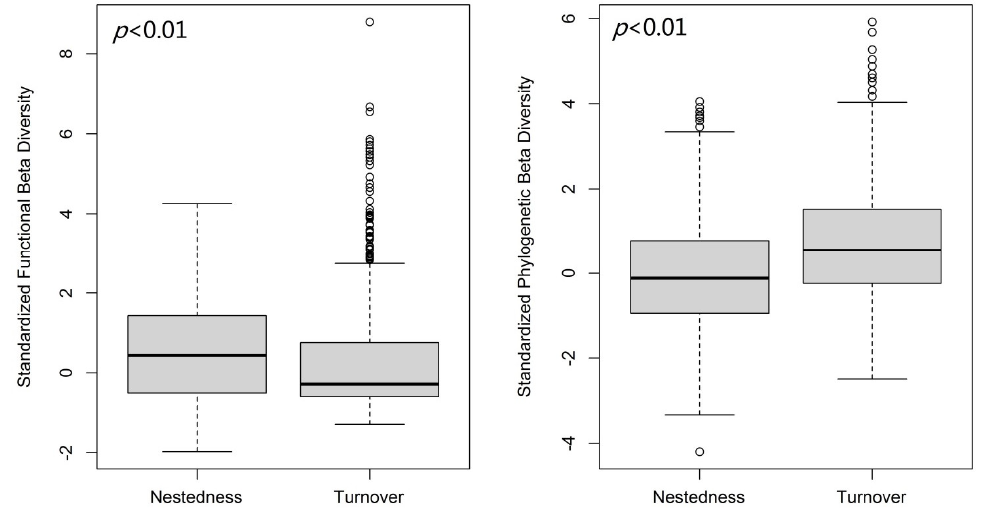
Figure 3. Results of the paired t -test of standardized functional and standardized phylogenetic turnover against their nestedness components. Nestedness of standardized functional beta diversity was significantly higher than its turnover component. In contrast, nestedness of standardized phylogenetic beta diversity was significantly lower than its turnover component. The circles in the figure were some extreme values.